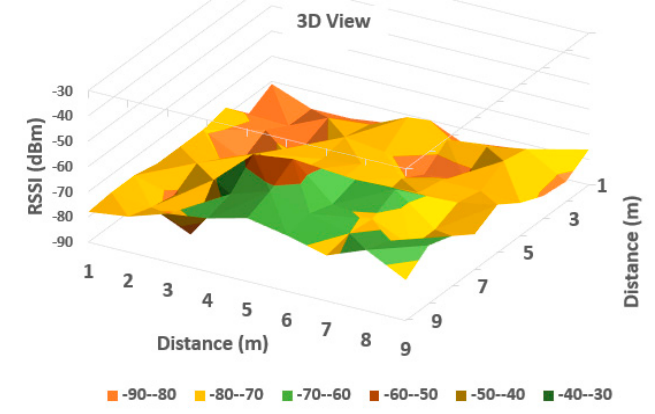
Figure 7. A three-dimensional representation of signal variation with different coloring according to RSSI measured values (Measurement point: MeS 1 ).